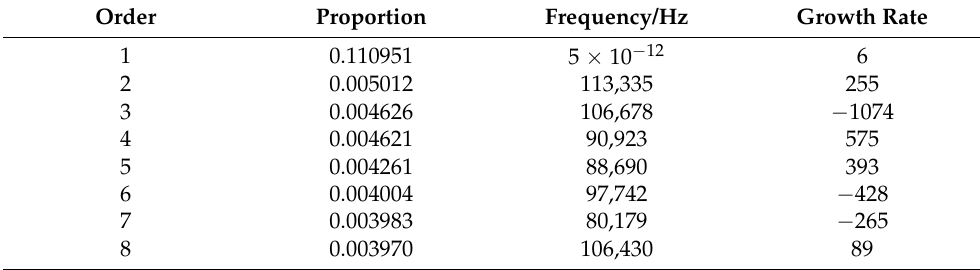
Table 6. Modes’ characters of the first eight modes in Case 1.